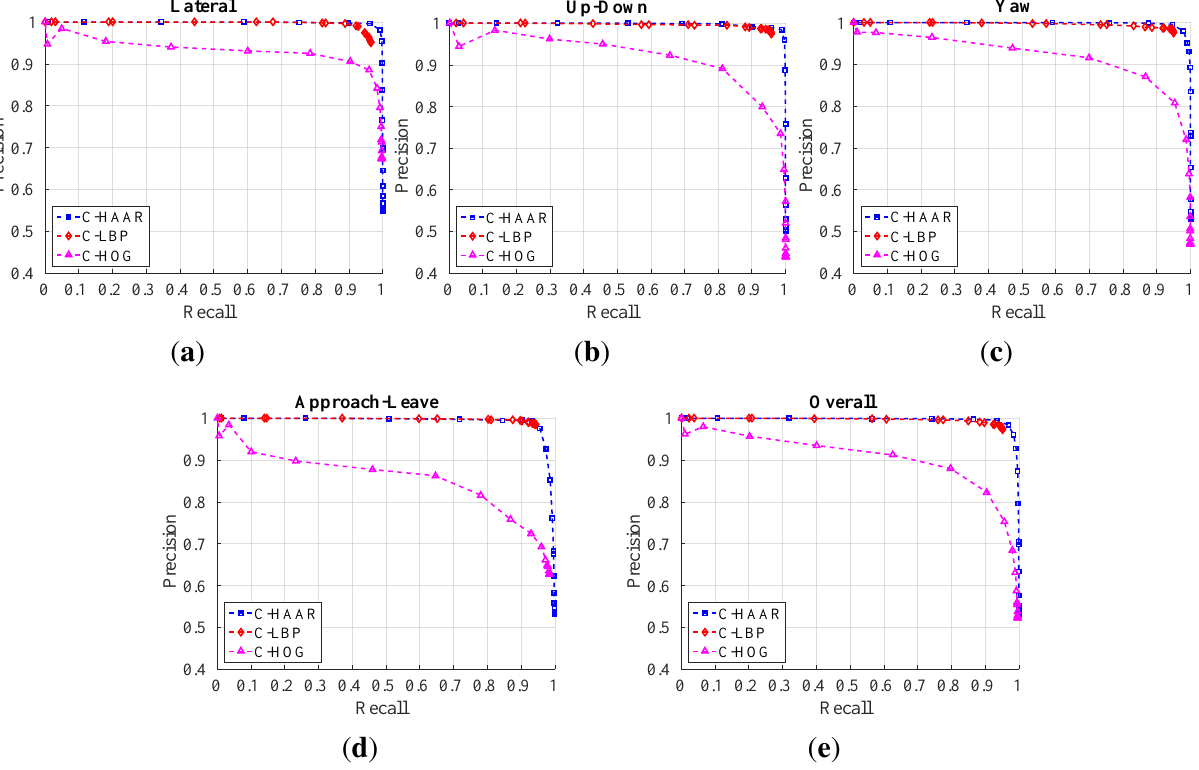
Figure 12. PR curves for: ( a ) lateral left-to-right and right-to-left; ( b ) up and down; ( c ) yaw clockwise and counter-clockwise; ( d ) approach and leave; and ( e ) all motion